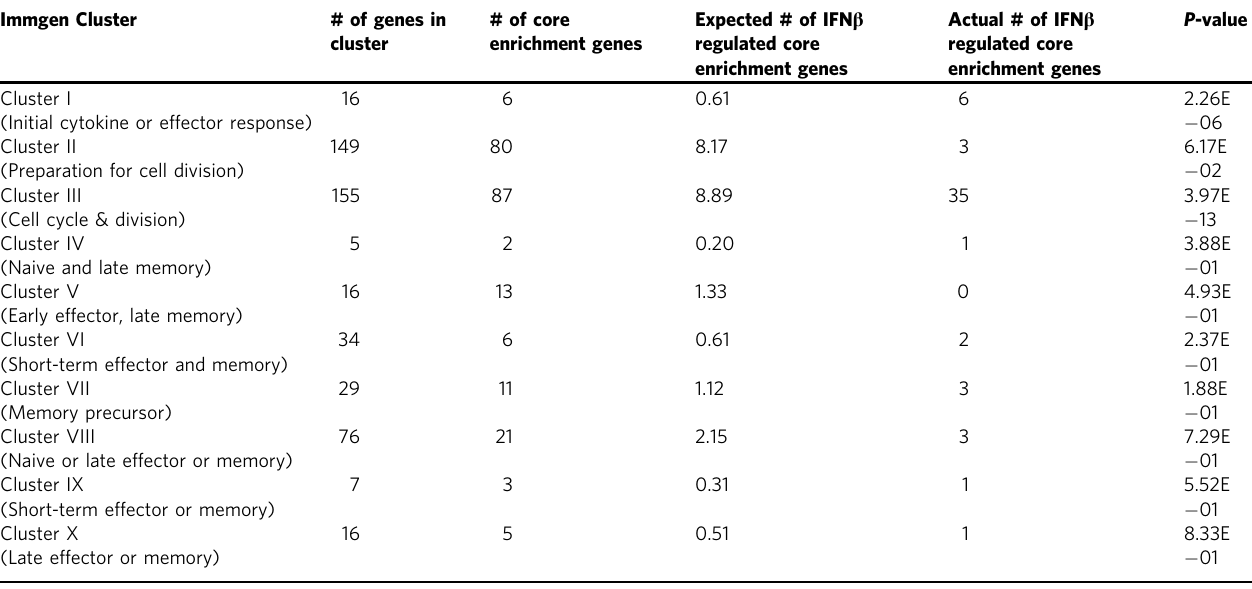
Table 1 In fl uence of IFN- β on core enrichment genes of Immgen clusters between CD5 lo and CD5 hi naive CD8 + T cells. Immgen Cluster # of genes in # of core cluster enrichment